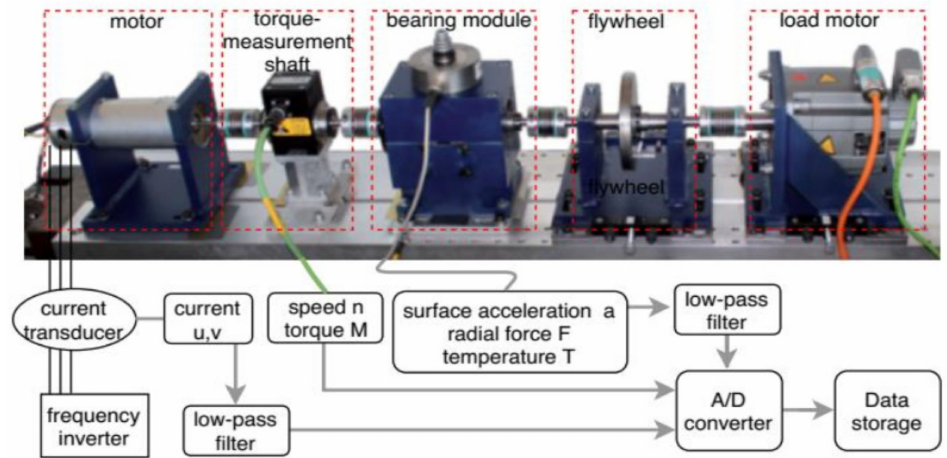
Figure 5. Organization of the UPB bearing test rig.